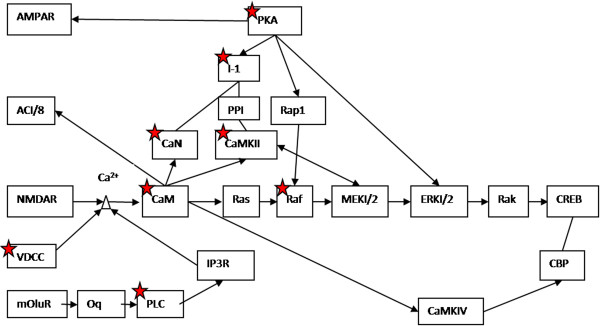
The 9 relative genes marked with red stars:
Ppp1r1a
(I-1),
Ppp3r1
(CaN),
Raf1
(Raf),
Camk2b
(CaMKII),
Ppp3ca
(CaN),
Prkacb
(PKA),
Cacna1c
(VDCC),
Plcb1
(PLC), and
Calm2
(CaM) in the most significant identified pathway, i.e., long-term potentiation.